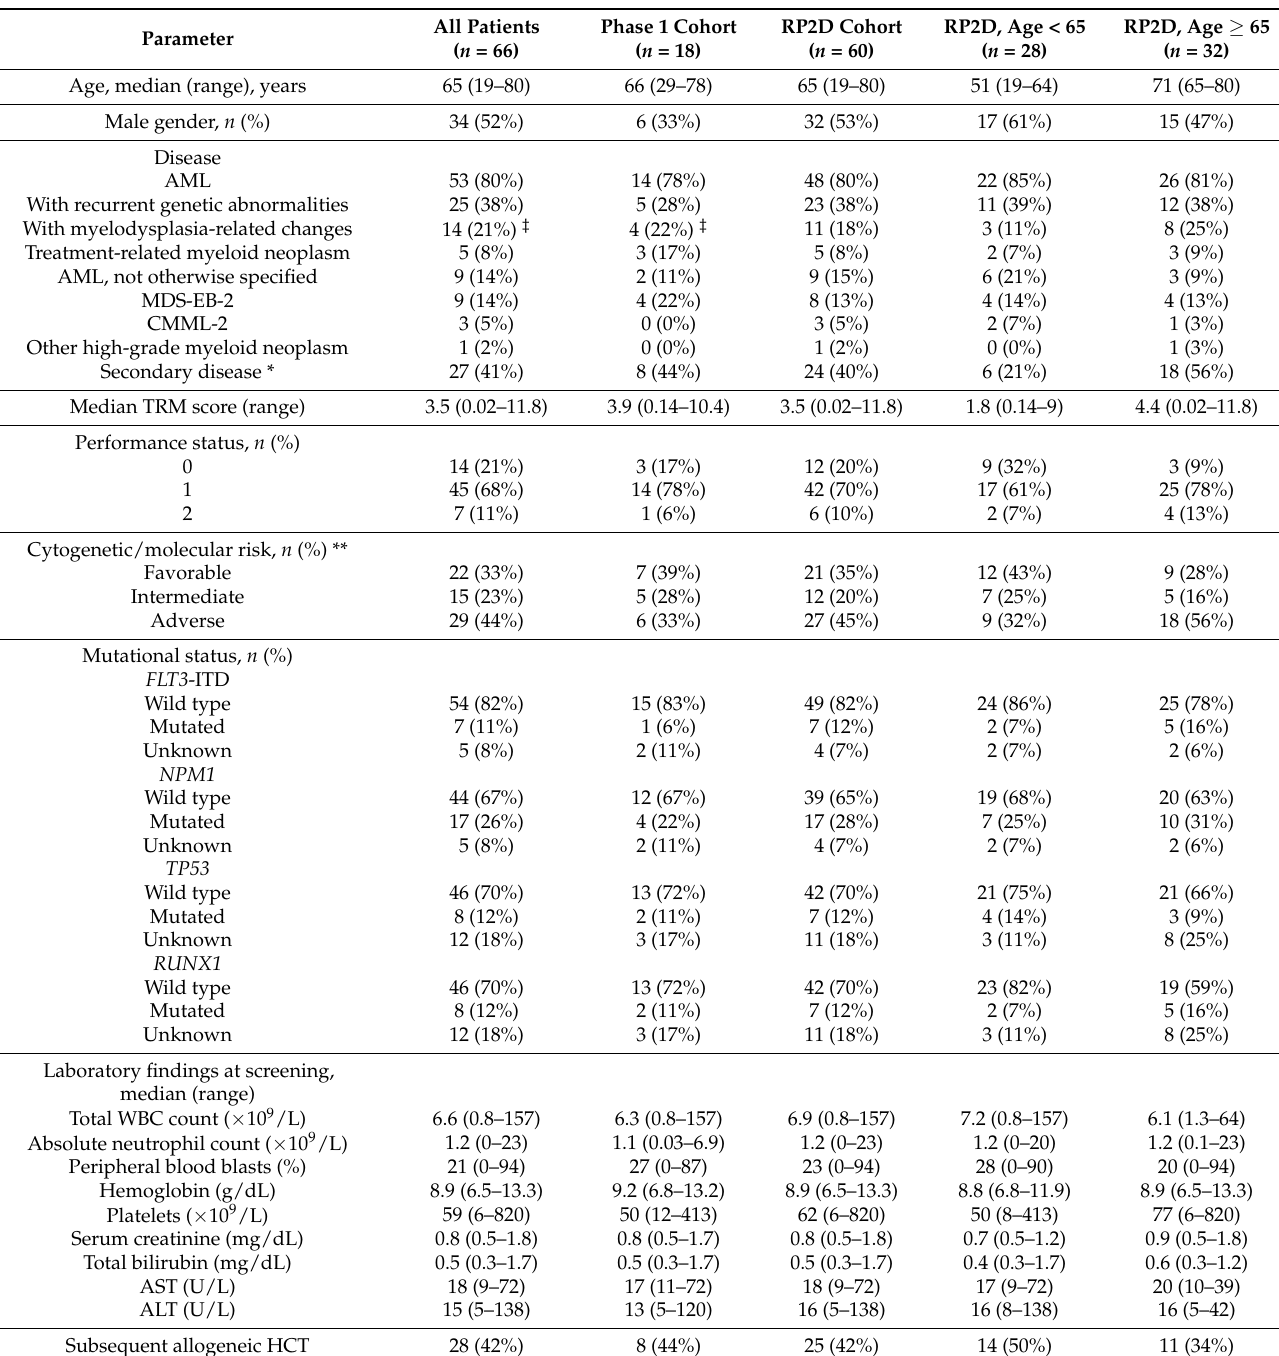
Table 1. Characteristics of CLAG-M/GO study